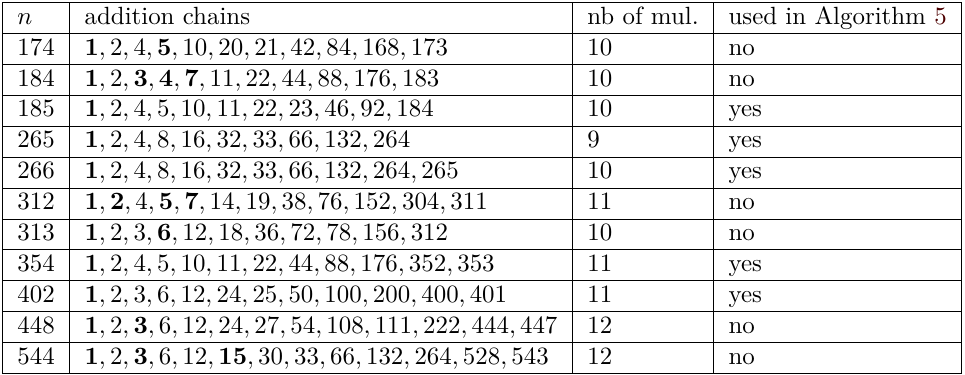
Table 25: Proposed addition chains to minimize the number of multiplications in F 2 n . The bold numbers are used to create some numbers of the